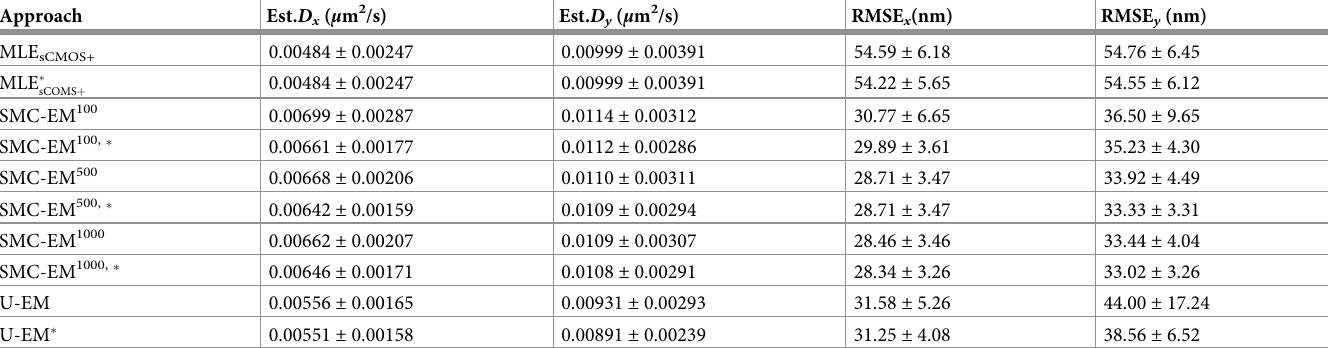
Table 5. Algorithm performance at G = 10, N bgd = 10, D x = 0.005 μ m 2 /s, D y = 0.01 μ m 2 /s with pixel-dependent readout noise. Approach